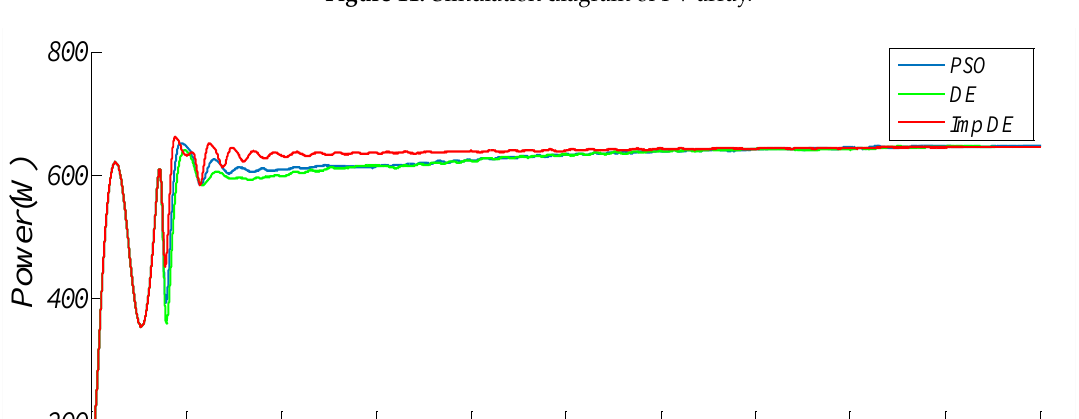
Figure 11. Simulation diagram of PV array. Table 1. Parameters of simulation components.